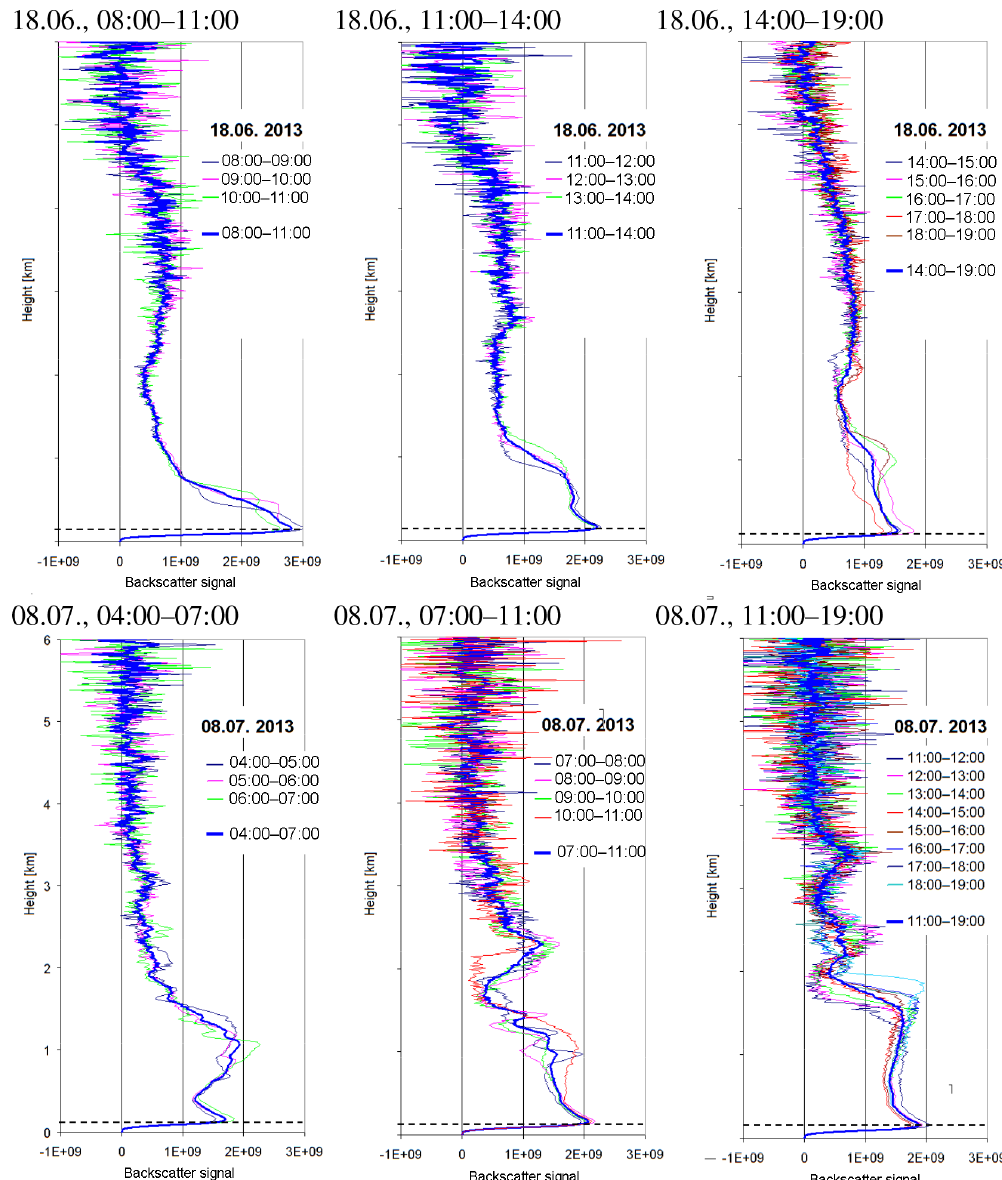
Figure A29. Range-corrected backscatter profiles (hourly averages) for the three selected periods on both days. Also, the averages over the whole periods are shown (thick lines). Note that the backscatter signal below 180m (below the dashed horizontal line) is invalid due to the limited overlap of the ceilometer